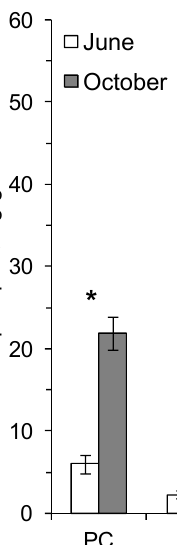
Table 3. Contents of fatty acids (mg / g of dry weight and % of total FA ± standard error) in the leaves of the perennial cereal Bromopsis inermis before mowing—07.07.2013 (July) and after mowing—25.09.2013 (September), and values of Student’s t -test ( t ).